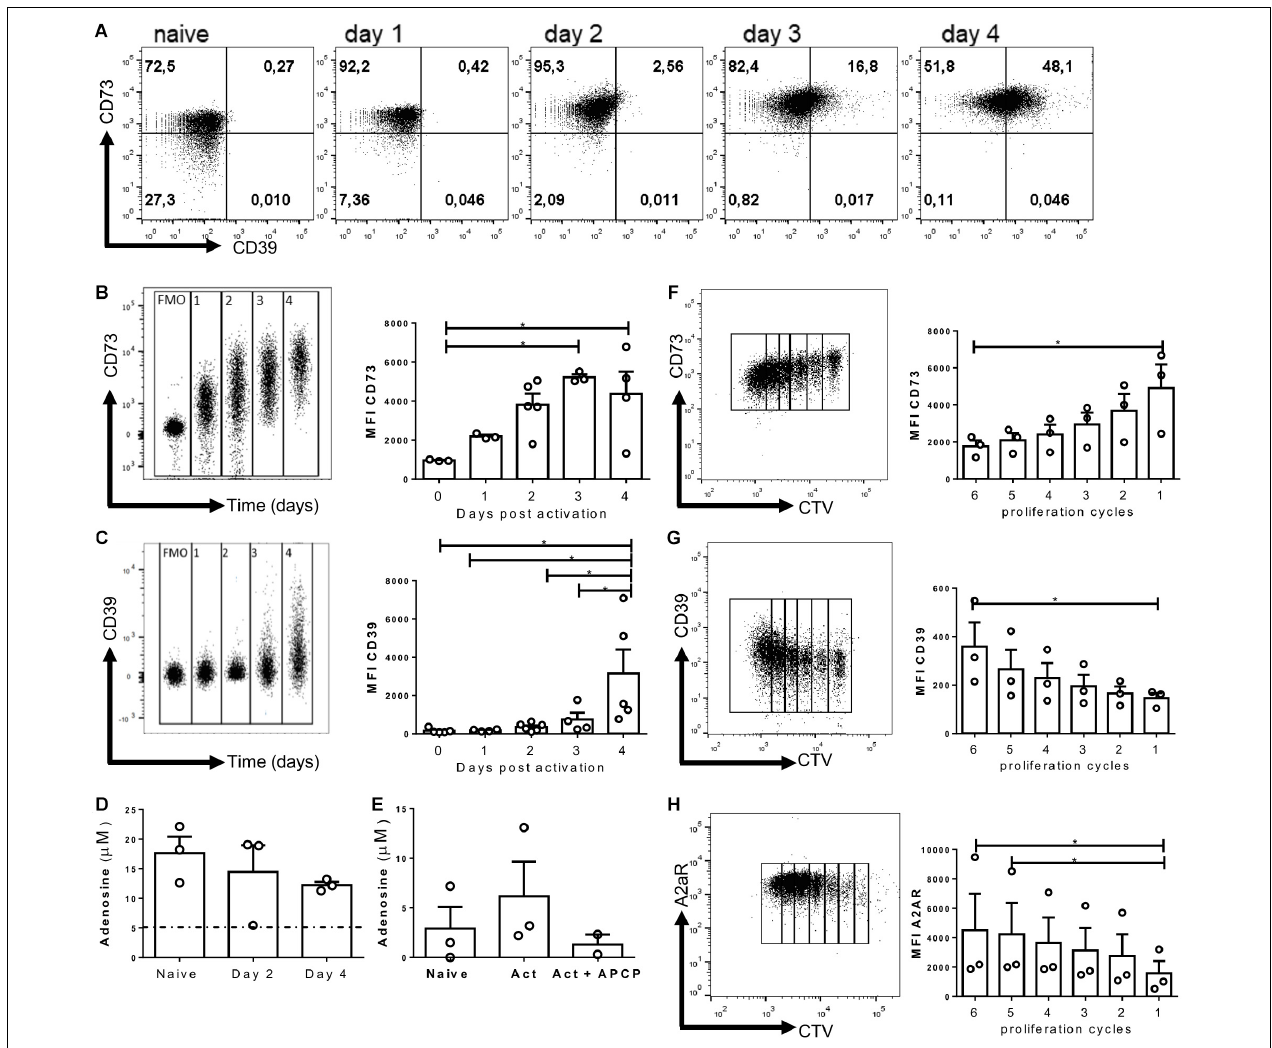
FIGURE 1 | Purinergic components are upregulated during in vitro activation. Naive CD8+ T cells from WT mice were isolated and activated with soluble α -CD3/CD28 antibodies for 4 days in vitro in the presence of IL-2 (10 ng/ml) for the generation of Tc1 lymphocytes. (A) Representative dot plots of CD39 and CD73 expression by in vitro -generated Tc1 cells at different time points. (B,C) Representative graph showing the concatenation and MFI of CD73 (B) and CD39 (C) on T cells at different days following activation. (D) Adenosine concentration obtained from naïve cells and in vitro Tc1 cultures at days 2 and 4 following activation. (E) Adenosine production by Tc1 cells cultured for 1 h in the presence of AMP (10 µ M) and APCP (50 µ M). (F–H) Representative dot plots and MFI graphs showing CD73 (F) , CD39 (G) , and A2AR (H) expression as a function of Tc1 proliferation cycles (at day 3) as assessed by cell trace violet dilution by FACS. Kruskal–Wallis Test, * p < 0.05, n = 3, Data is presented as the mean ±